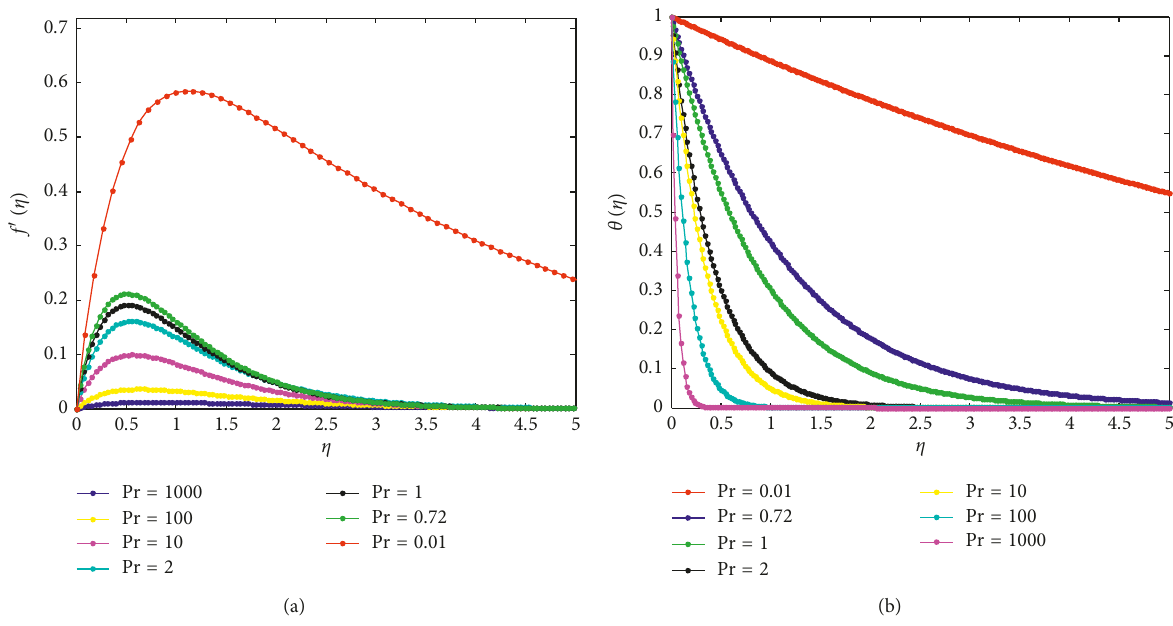
Figure 13: (a) Effects of Prandtl number on the velocity profile for cylindrical-shaped nanoparticle. (b) Effects of Prandtl number on the temperature profile for cylindrical-shaped